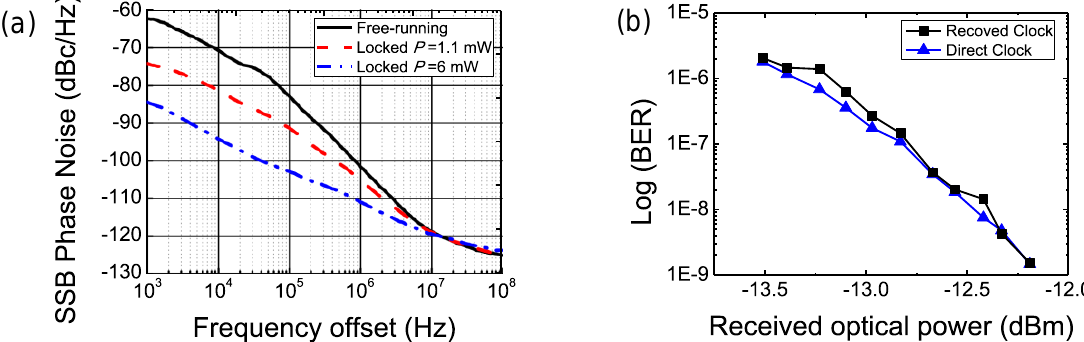
Figure 9. ( a ) SSB phase noise of free-running and recovered clock signals. ( b ) BER measurements of recovered and direct